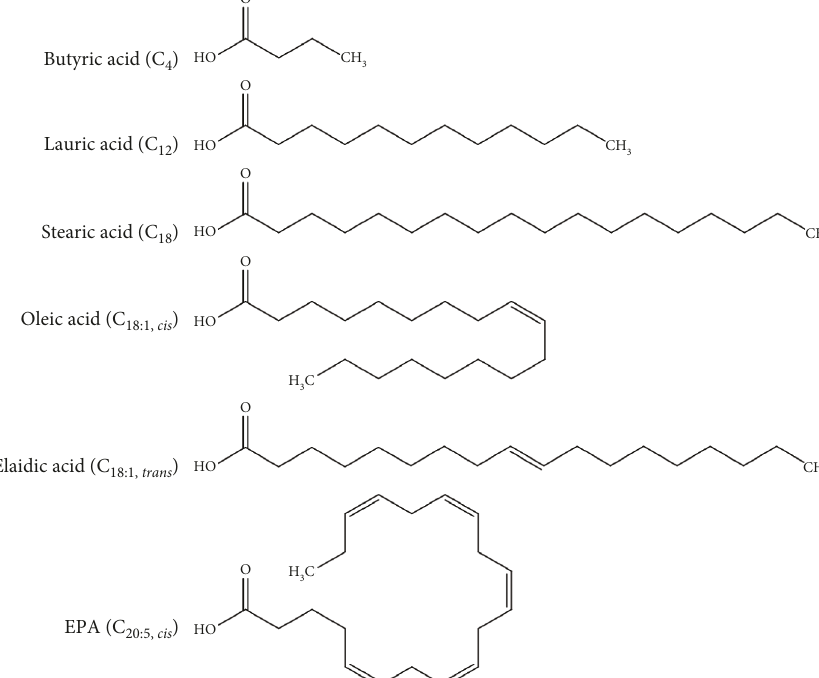
Figure 2: Examples of each type of fatty acid. Butyric acid is a minimum short-chain saturated fatty acid with four carbons (C be hydrolyzed by lipases. Lauric acid is a medium-chain saturated fatty acid with twelve carbons (C 12 ), which is rich in coconut and palm kernel oil. Stearic acid is a long-chain saturated fatty acid with eighteen carbons (C 18 ), which is more abundant in animal fat. Oleic acid is a monounsaturated fatty acid with eighteen carbons (C 18 ) and one cis double bond in C 9 . Elaidic acid is a trans geometric isomer of oleic acid. Notably, elaidic acid has almost the same topology as stearic acid. Eicosapentaenoic acid (EPA) is a polyunsaturated fatty acid with twenty carbons (C 20 ) and five cis double bonds in C 5 , C 8 , C 11 , C 14 , and C 17